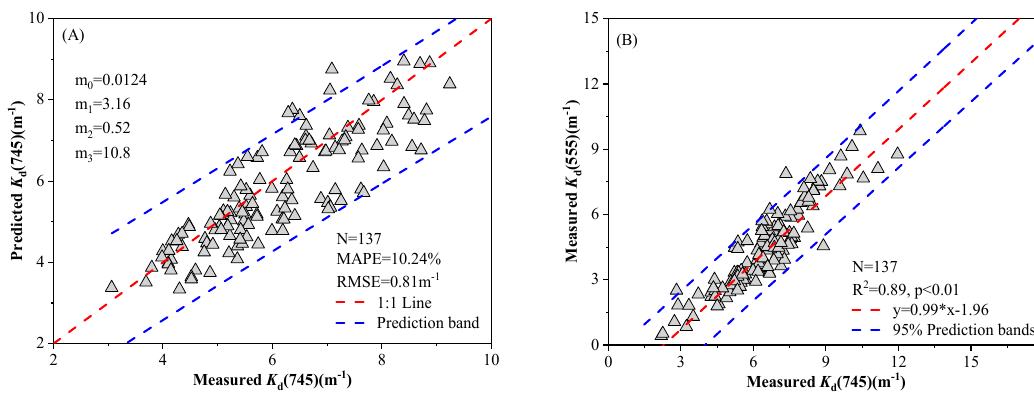
Figure 2. Comparison between measured and the model derived values of K d (745) ( A ). The in-situ relationships between K d (745) and K d (555) ( B ).